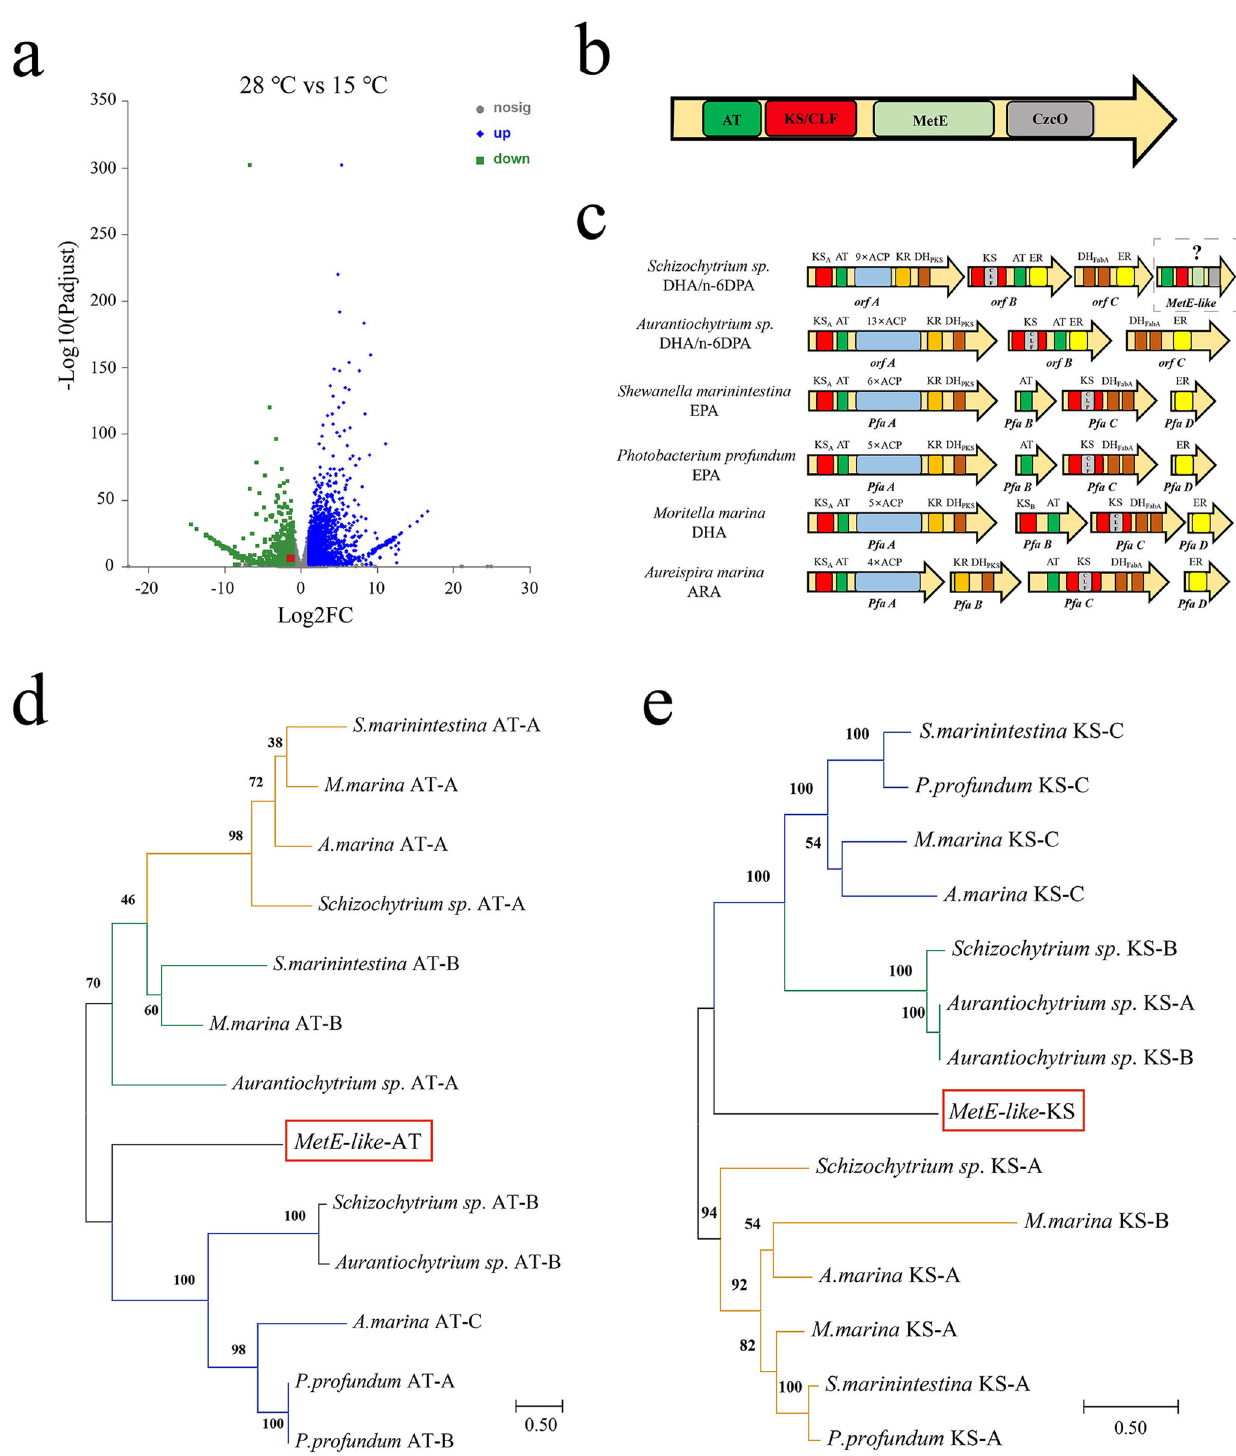
Fig. 3 Identifying a MetE-like domain relevant to EPA synthesis. a Volcano plot of the whole transcriptome. Blue and green dots represent proteins with obviously increased and decreased levels, respectively, gray dots represent genes with similar transcript levels under two growth conditions ( MetE-like is circled in red). b Functional domains included in MetE-like . c Structure of PKS pathway from microorganisms. DH Dehydratase, KR Ketoacyl-ACP reductase. d , e Maximum Likelihood phylogenetic analysis was performed with all AT ( d ) and KS ( e ) domain sequences from Schizochytrium sp., Aurantiochytrium sp., several bacteria and MetE-like